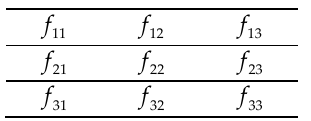
Figure 8. 3 × 3 filter evaluation window.